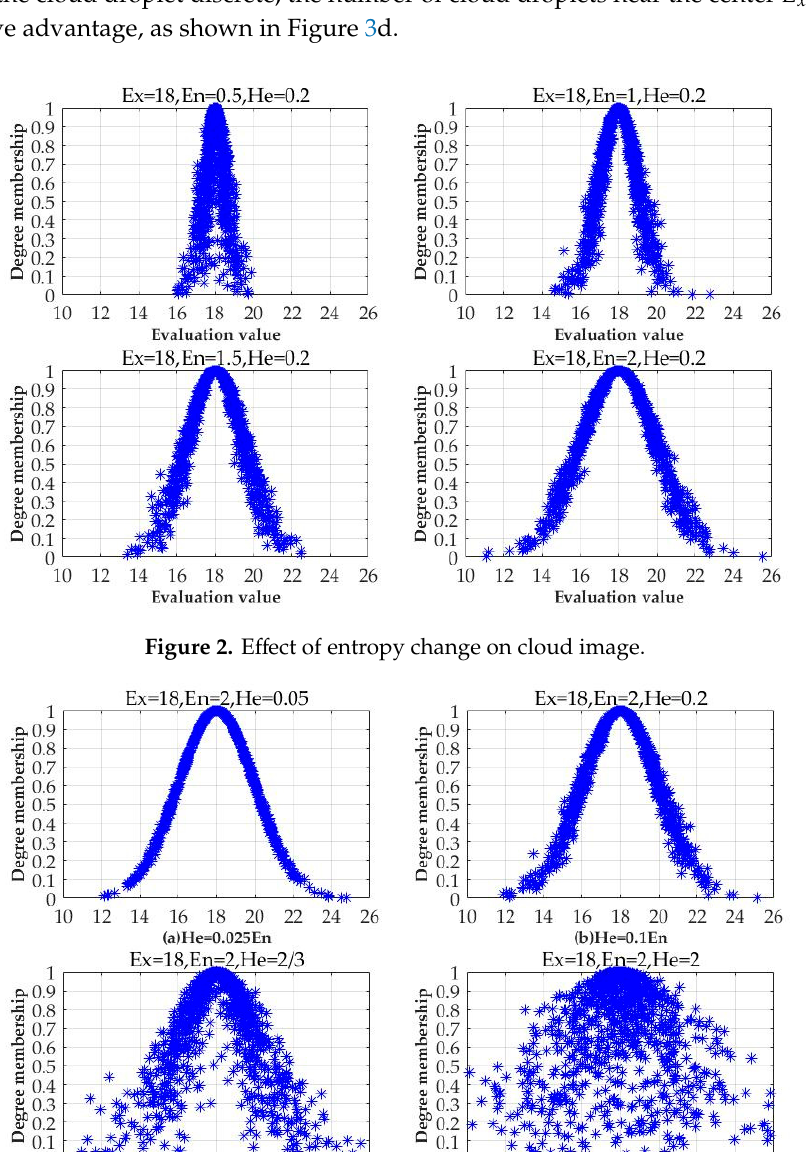
Figure 3. Effect of Hyper entropy change on cloud image. Figure 3. E ff ect of Hyper entropy change on cloud